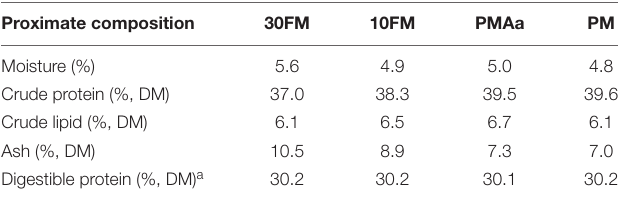
TABLE 5 | Chemical composition of experimental diets. Proximate